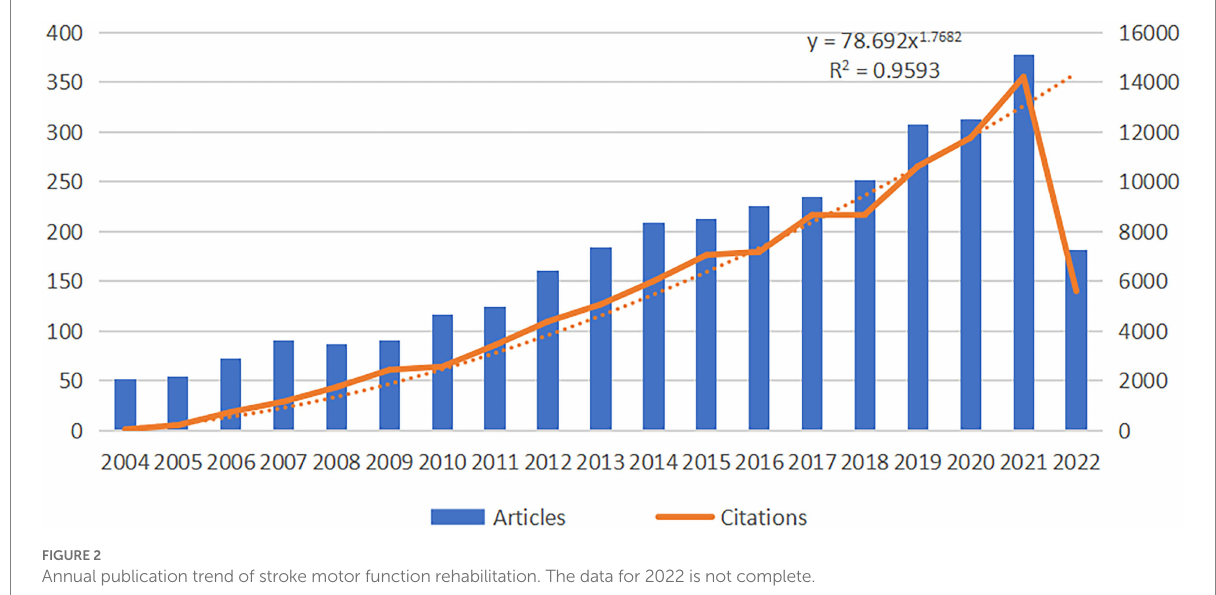
FIGURE 2 Annual publication trend of stroke motor function rehabilitation. The data for 2022 is not complete.